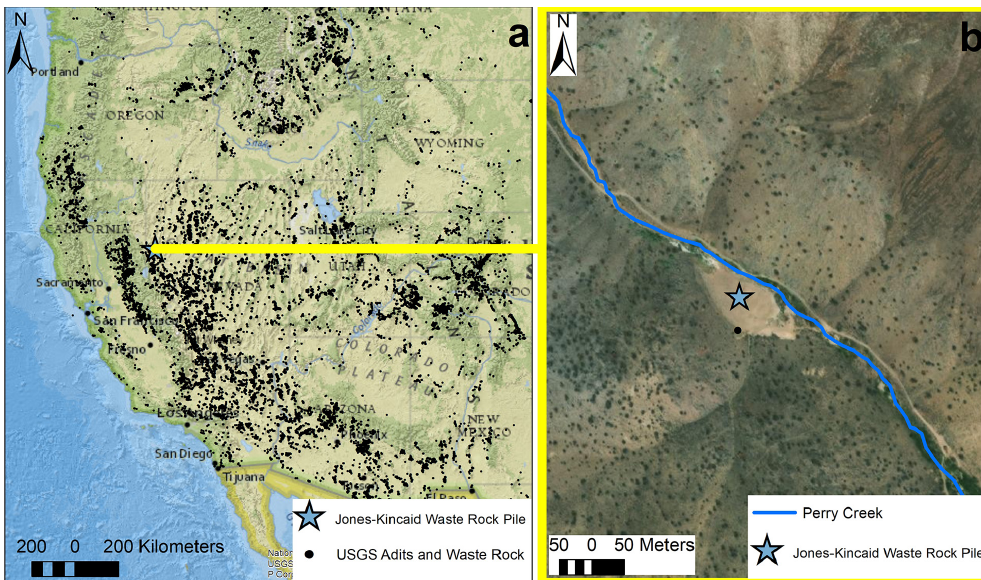
Figure 1. ( a ) Map of abandoned adits and waste rock piles, highlighitng the extent of inactive and active mine inventory in the Western U.S. [19]; The Jones-Kincaid Waste Rock Pile in Perry Canyon, NV is indicated using a blue star. ( b ) Jones-Kincaid Waste Rock study area and adjacent Perry